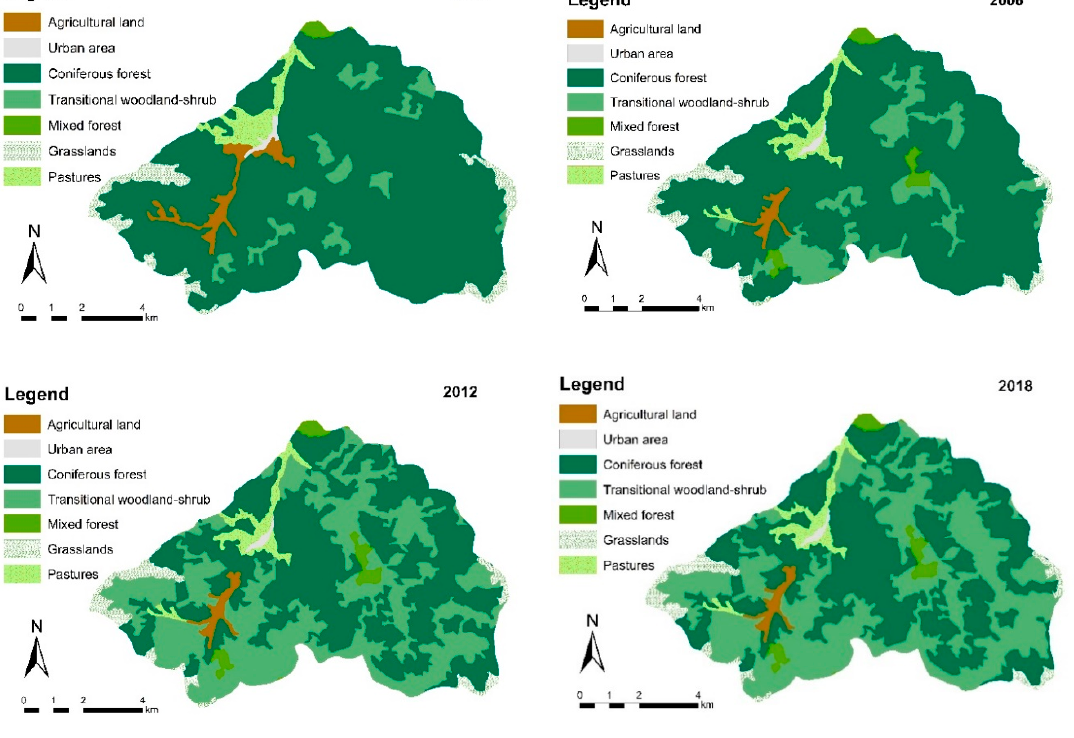
Figure 3. Boca River basin—CORINE Land Cover 1990, 2006, 2012, and 2018 .